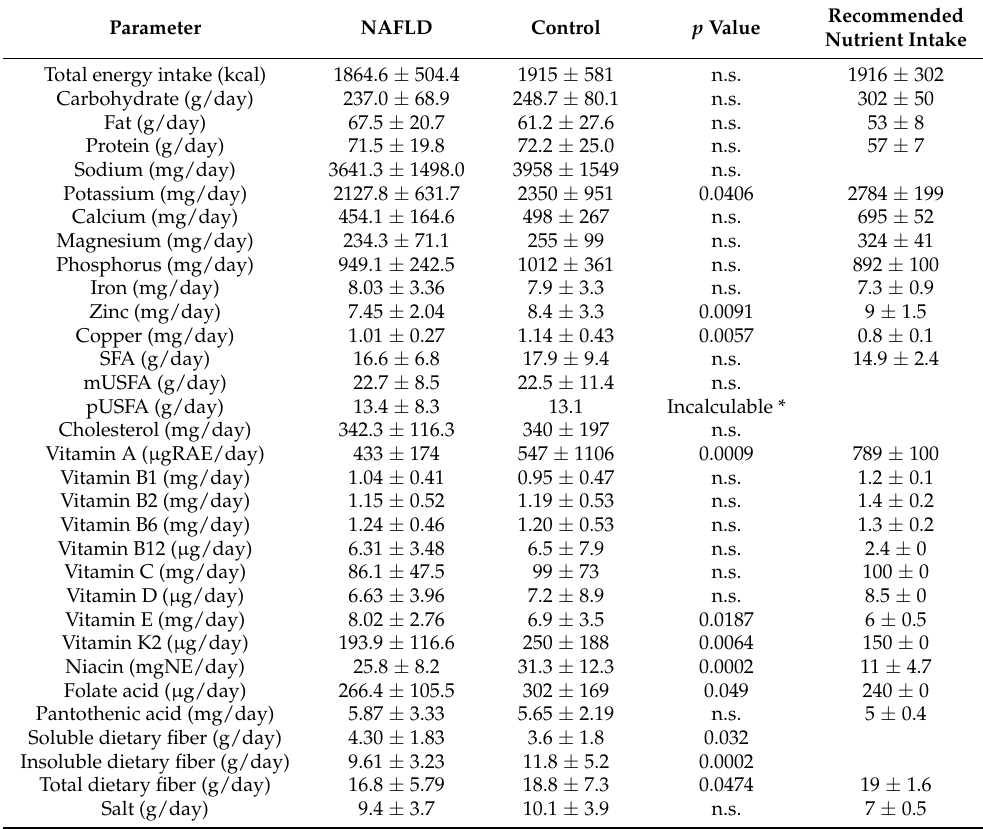
Table 3. Comparison of nutrient intake data (NAFLD group, control group).